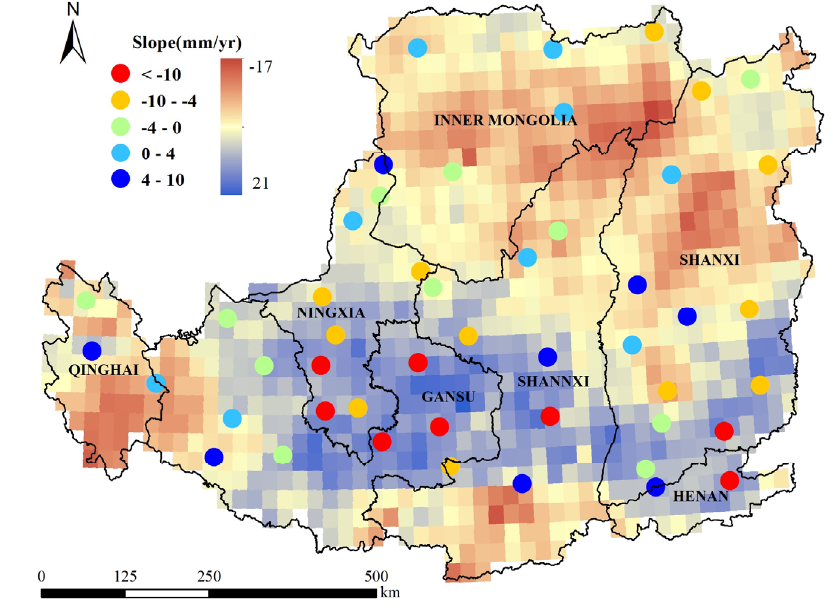
Figure 7. Trends of annual precipitation based on TRMM and station observation data across the Loess Plateau.